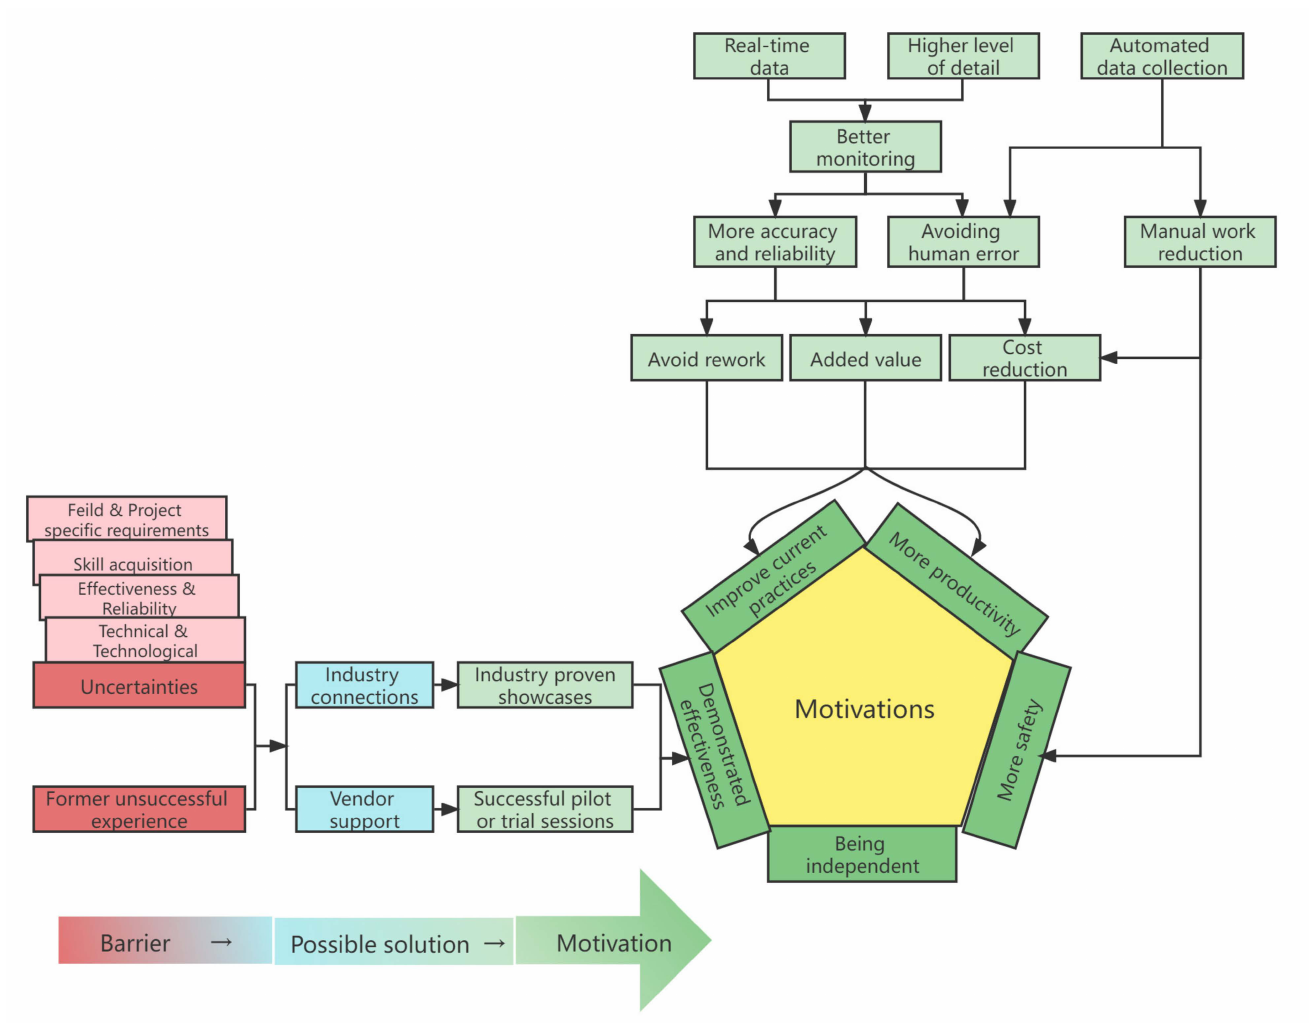
Figure 15. Motivating